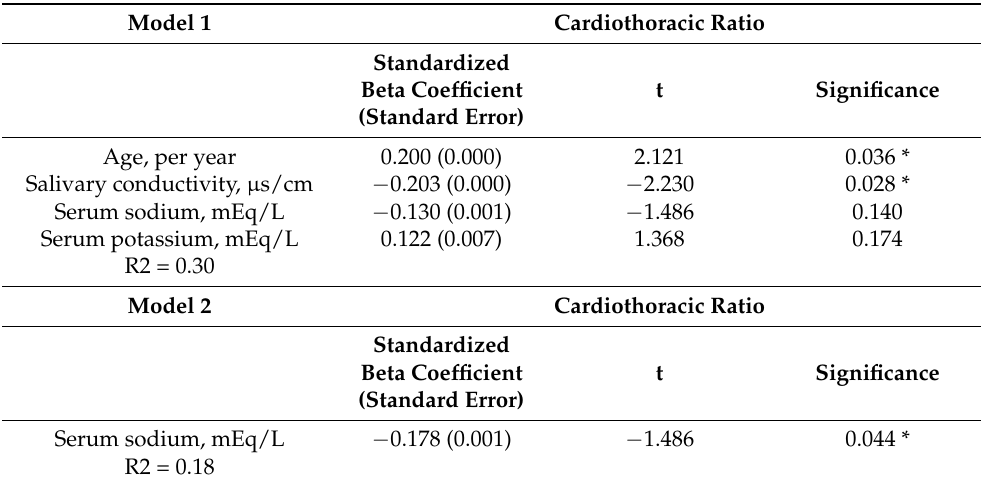
Table 2. Prediction of the cardiothoracic ratio from clinical data and salivary conductivity by multiple linear regression